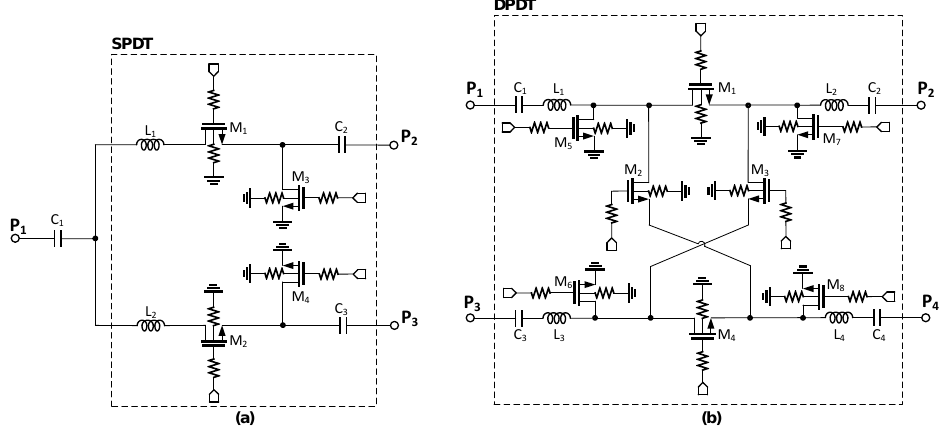
Figure 4. Circuit schematics of the SPDT ( a ) and DPDT ( b ) switches.